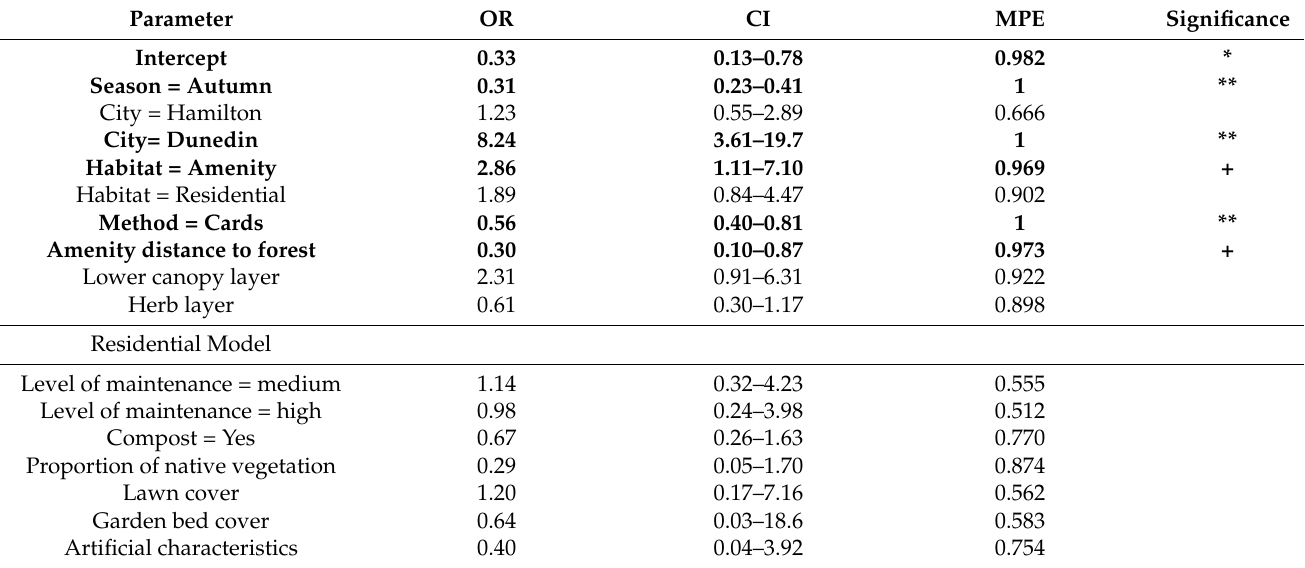
Table 3. Hedgehogs: summary statistics for coefficients of the parameters in the main hedgehog model and additional residential model